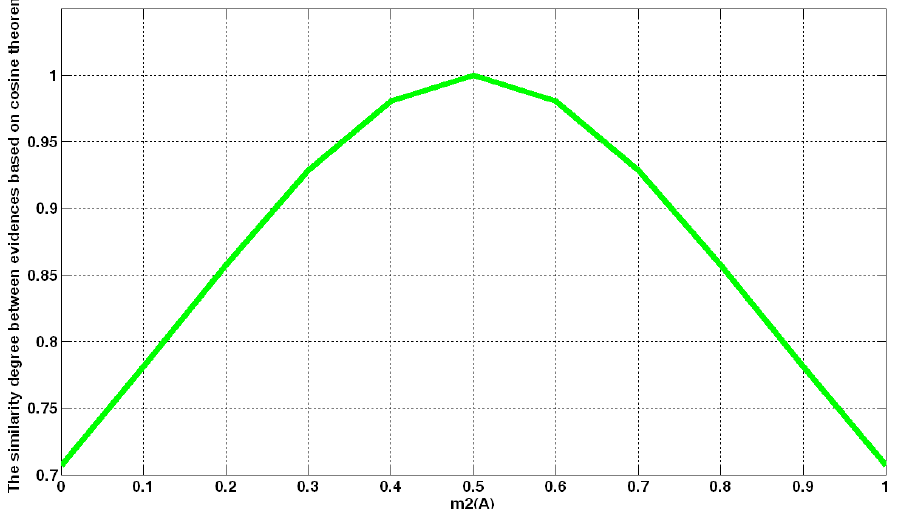
Figure 3. The similarity of the evidences E 1 and E 2